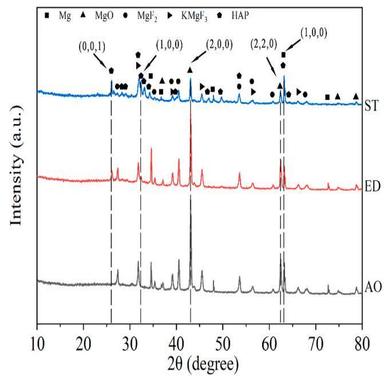
XRD patterns of prepared samples.